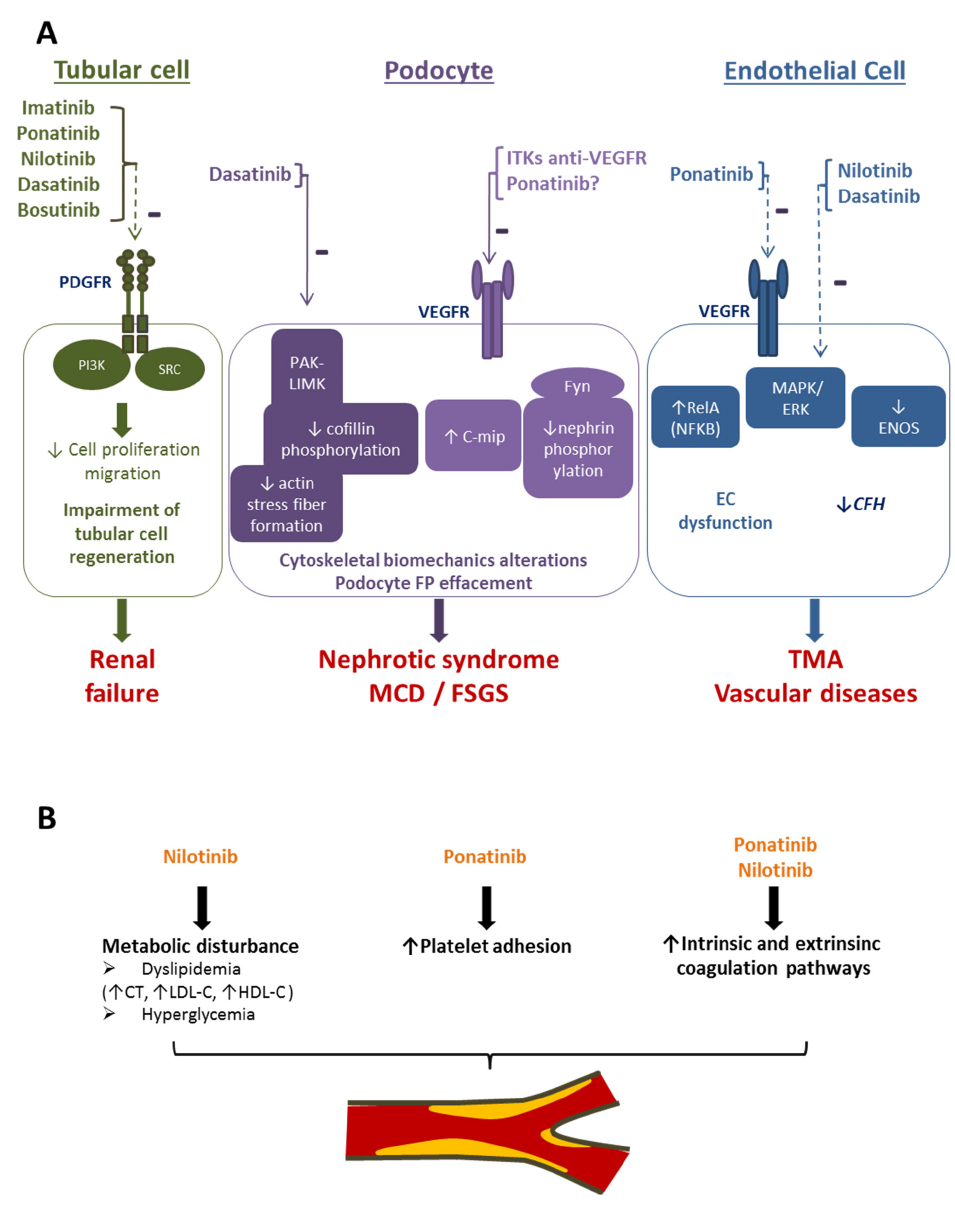
Figure 2. Schematic representation of signaling cascades and their inhibition by BCR-ABL tyrosine kinase inhibitors. ( A ) Renal off-target of BCR-ABL tyrosine kinase inhibitors and the related renal diseases. The five BCR-ABL TKIs exert an inhibitory effect on PDGFR. PDGFR signaling pathways are involved in tubular cell regeneration [29,30]. Dasatinib specifically inhibits PAK–LIMK path- ways, resulting in a decrease in cofillin phosphorylation, thus altering actin stress fiber formation and leading to cytoskeletal alterations, podocyte FP effacement, and podocyte loss [12]. Ponatinib may also exert an inhibitory effect on VEGFR [33]. VEGFR inhibition by ITKs targeting this receptor (sunitinib) induces an increase in C-mip and a decrease in nephrin phosphorylation, both leading to cytoskeletal alterations and podocyte disorders, resulting in MCD and FSGS [33,34]. At the level